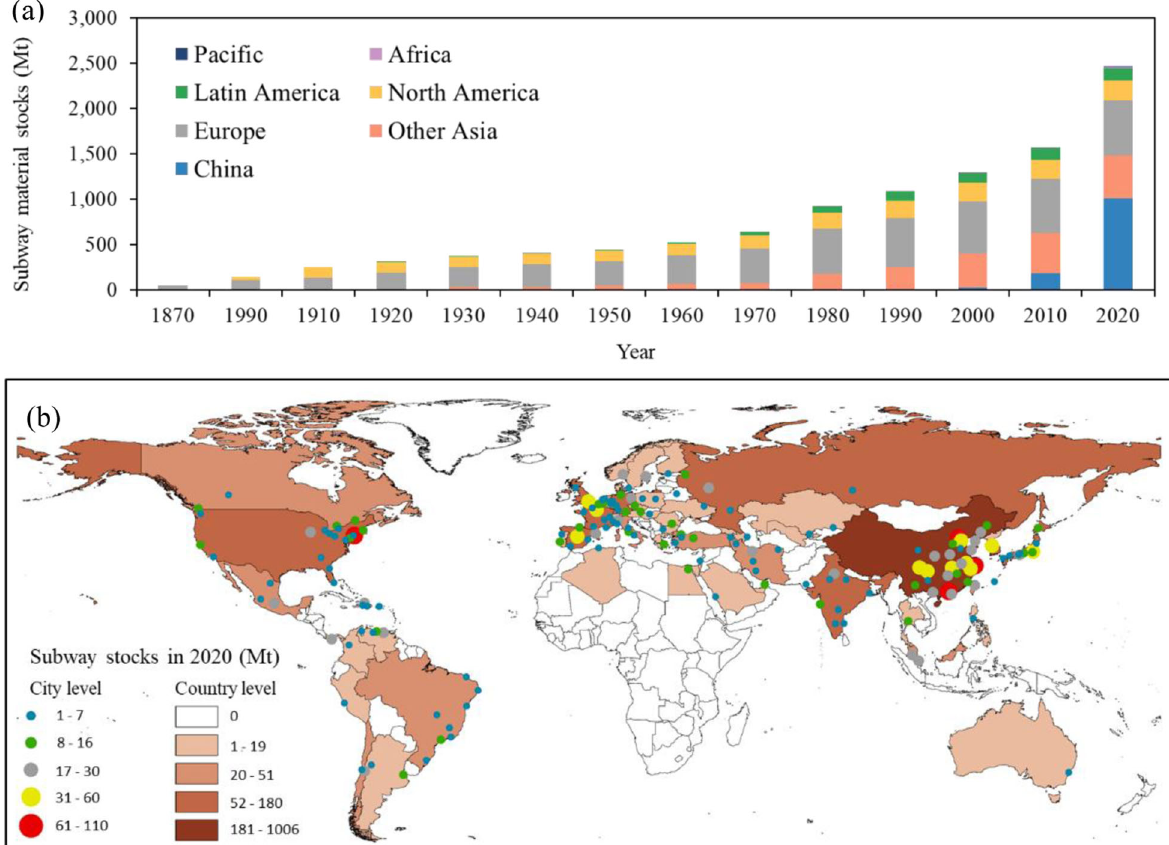
Fig. 4 The temporal and spatial patterns of global subway material stocks. ( a ) The temporal growth patterns by world region, 1870 – 2020; and ( b ) the spatial distribution at city and country levels by July